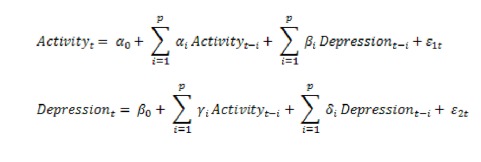
Figure 2. The endogenous variables for depression and physical activity used in this